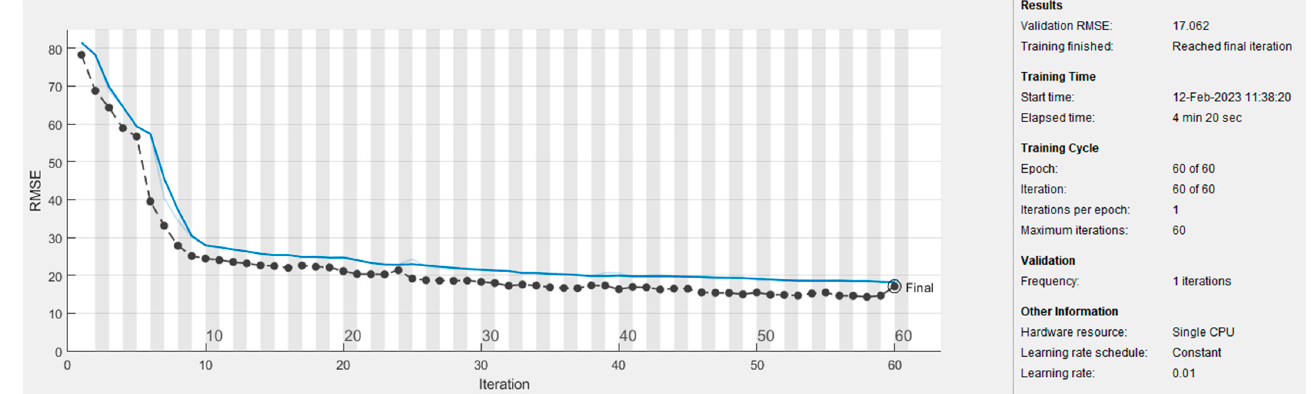
Figure 17. Training progress for the hybrid BA-LSTM algorithm (engine dataset).